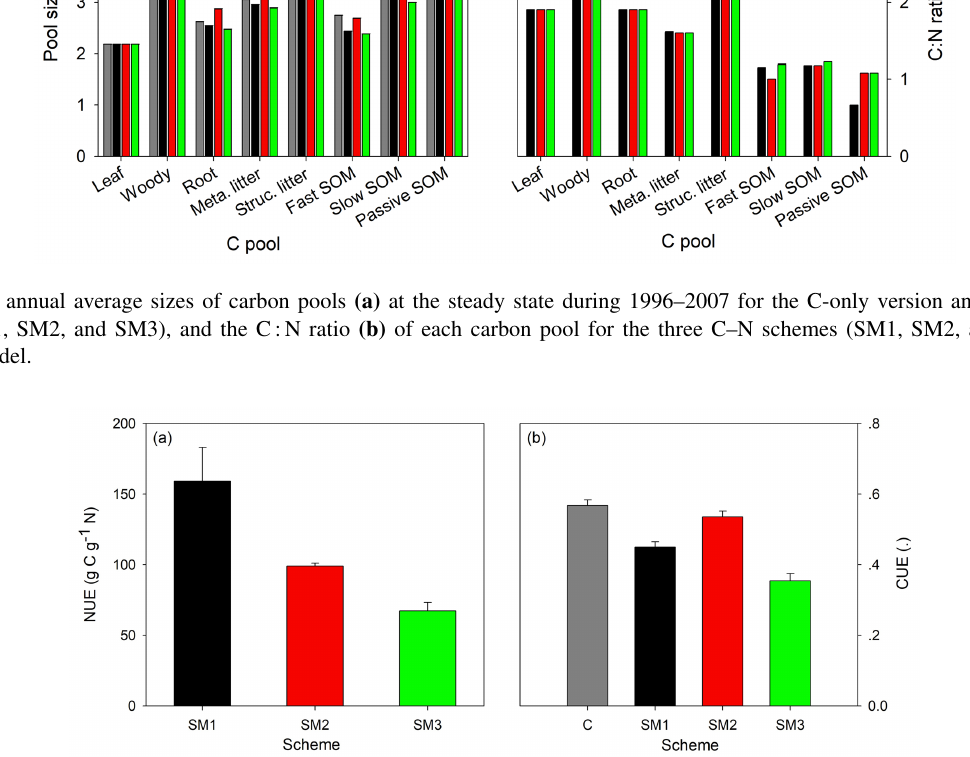
N uptake in SM3 had the highest sensitivity (0.87) for